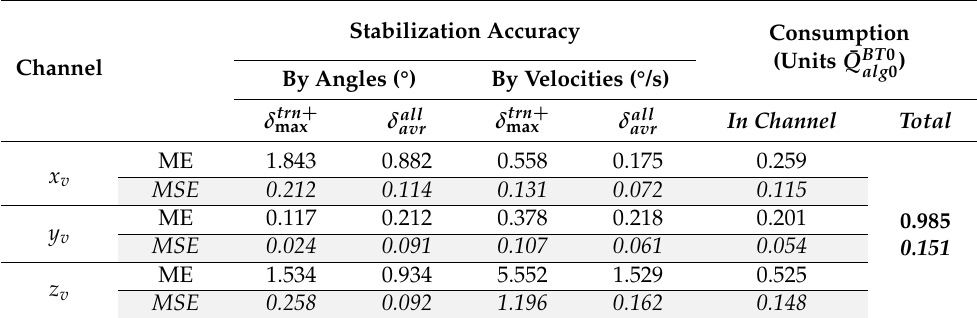
Table 7. Averaged statistics of spacecraft stabilization processes without roll overturns according to the new algorithm for the range of tensors of inertia and thrust of engines.